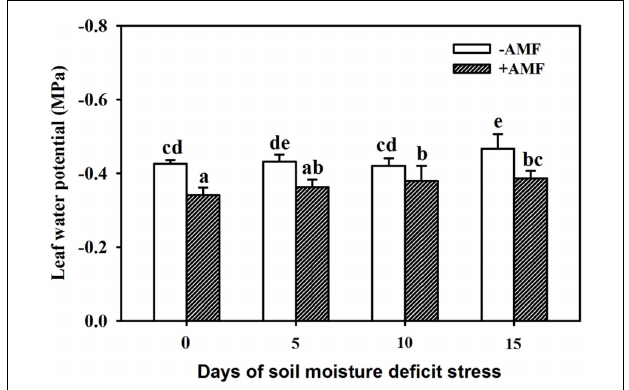
FIGURE 2 | Leaf water potential of trifoliate orange seedlings inoculated with and without Funneliformis mosseae during exposure to soil moisture deficit stress (SMDS) of 0-15 days. Data (mean ± SD, n = 4) followed by different letters above the bars indicate significant ( P < 0.05) differences.